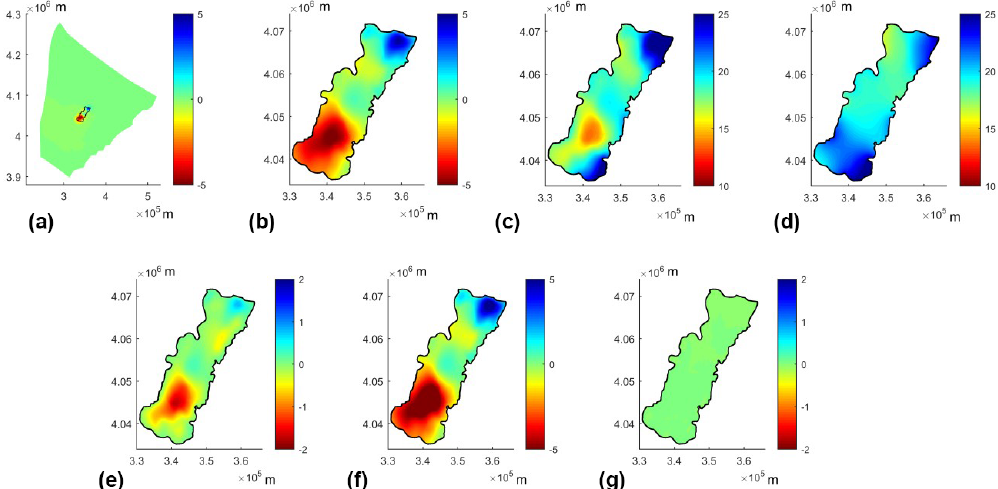
Figure 10. The spatial distribution of the groundwater head and its decomposition in Guantao at the final time step. (a) refers to the spatial distribution of head changes due to inside drivers calculated by the large model; (b) is a zoom into the large model showing only Guantao County ( (cid:49)h Guantao ); (c) is the groundwater head map of Guantao obtained from the Guantao model ( h Guantao ); (d) is the groundwater head distribution determined by outside drivers and obtained from the h out flow model ( h out ); (e) shows the inconsistency of (cid:49)h Guantao in the large model; (h) refers to the distribution of the updated (cid:49)h Guantao ; (g) shows the error of the updated (cid:49)h Guantao .